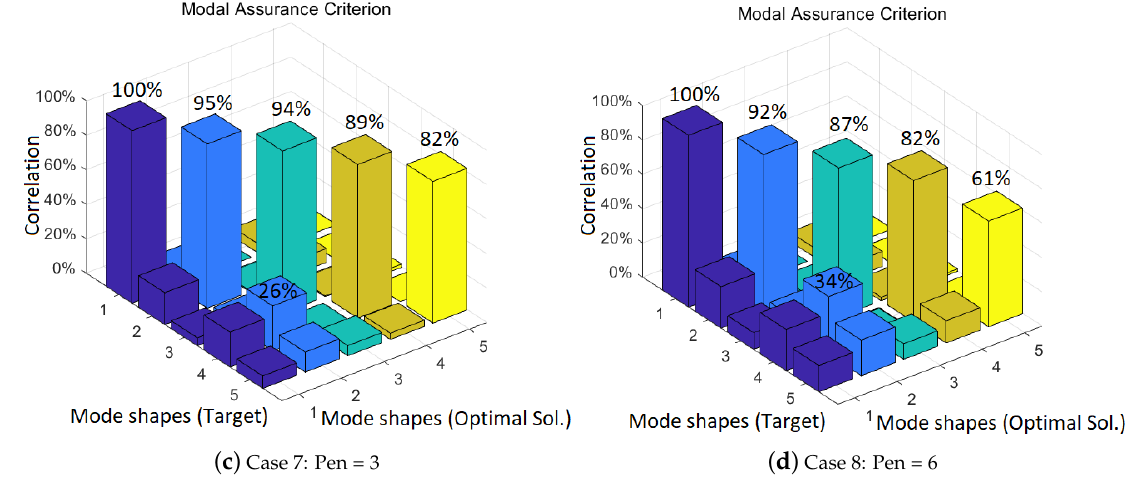
Figure 14. Modal Assurance Criterion for Cases 5, 6, 7 and 8.